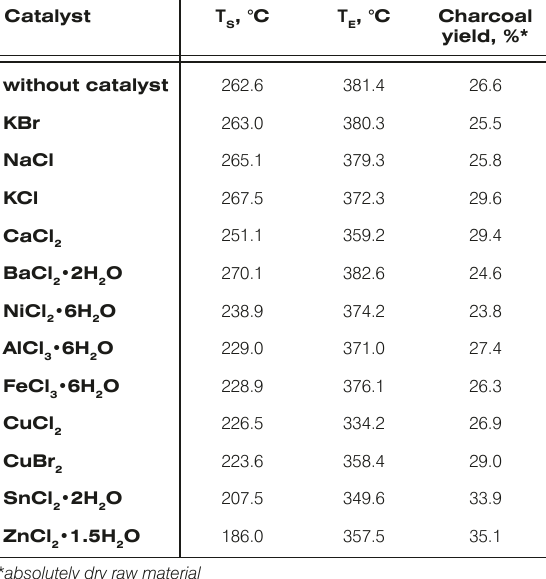
Table 3. Parameters of spruce wood pyrolysis in the presence of catalyst at heating rate 10°C min -1